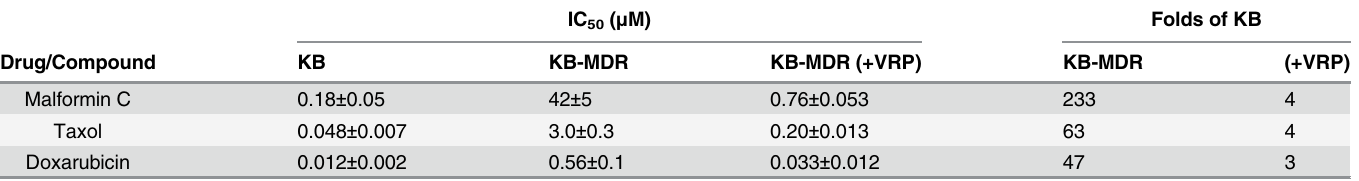
Note: Values were means ± SD from more than three independent experiments, with each data point done in duplicate, and all the cells were exposed to different drugs for 72 hours. Verapamil (VRP) was added to the media at a concentration of 5 μ M. VRP ’ s IC 50 of KB cells were 34 ± 1 μ M, and no toxicity was observed at 5 μ